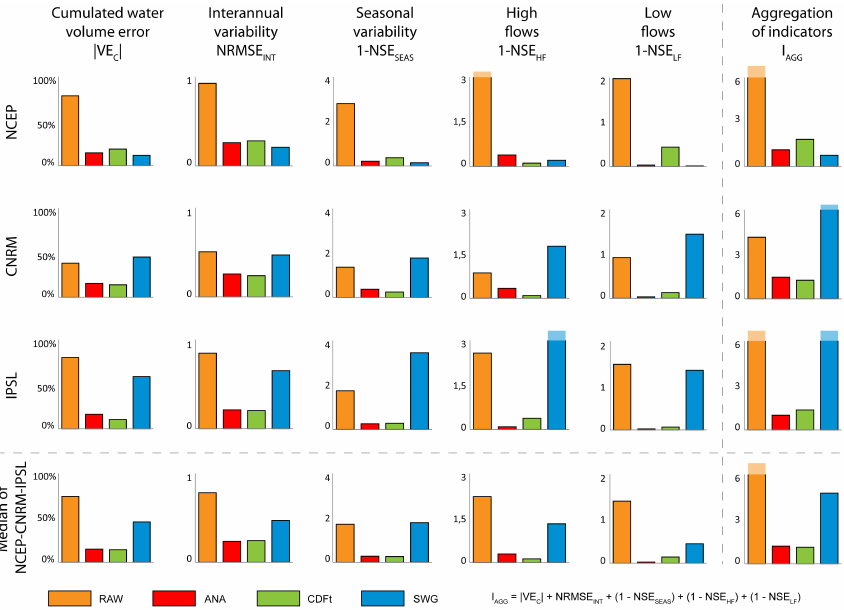
Figure 10. Efficiency of the different climatic data sets in reproducing different aspects of the hydrographs from the four basins over the period 1986–2005: comparison of low-resolution data sets (RAW) and high-resolution data sets downscaled using the ANALOG, CDFt or SWG methods forced by NCEP/NCAR reanalyses and outputs from the CNRM and IPSL. The bars represent the median of the indicator values of the four basins. The smaller the bar, the better the result. Row “Median of NCEP-CNRM-IPSL” corresponds to the median of the four basins for the three large-scale climate data sets (NCEP, CNRM and IPSL). Column “Aggregation of indicators” sums the six indicator values according to the following equation: I AGG = | VE C |+ NRMSE INT + ( 1 − NSE SEAS ) + ( 1 − NSE HF ) + ( 1 − NSE LF )